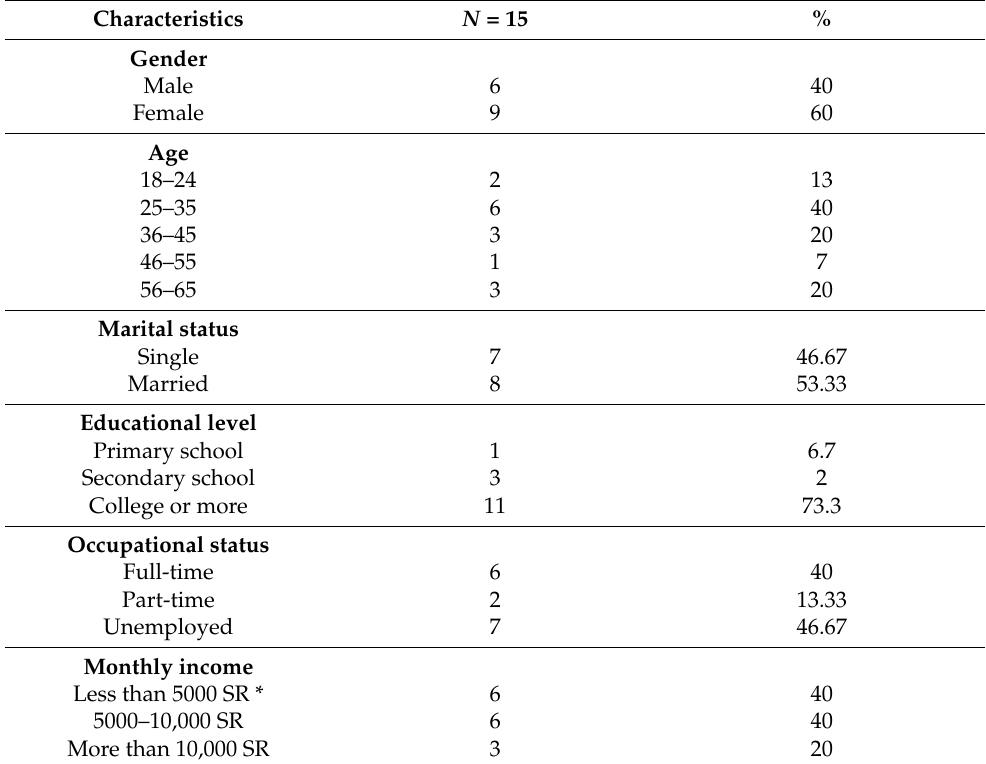
Table 3. Demographic data of the